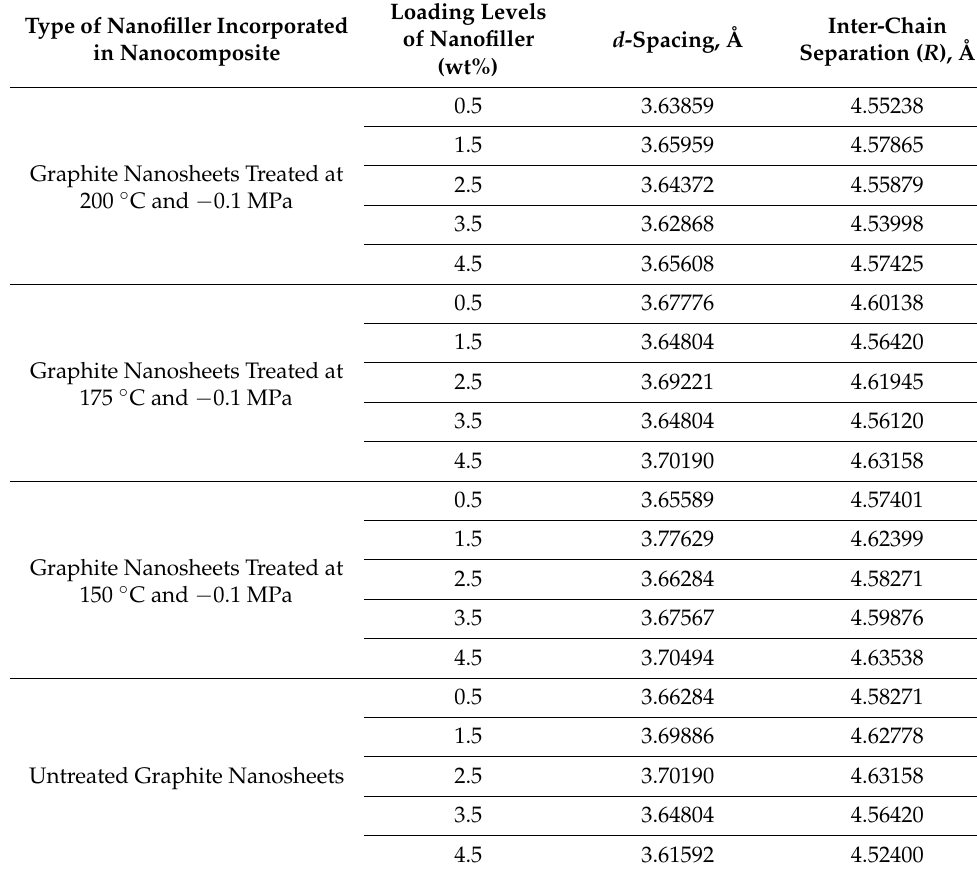
Table 3. d -Spacing and Crystallite Size for All 2 θ = 24.3 ◦ Peaks in Graphite Nanosheets/Nylon 610